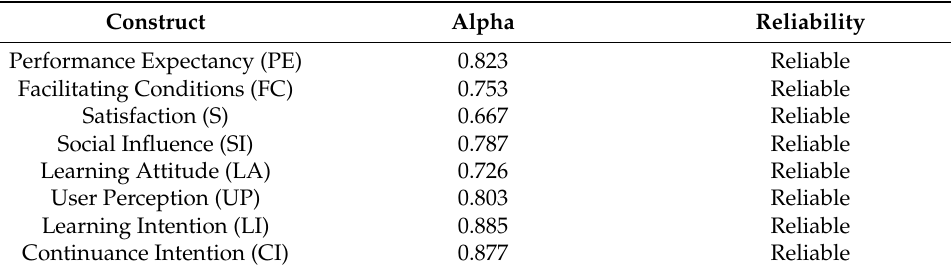
Table 6. Reliability test of the